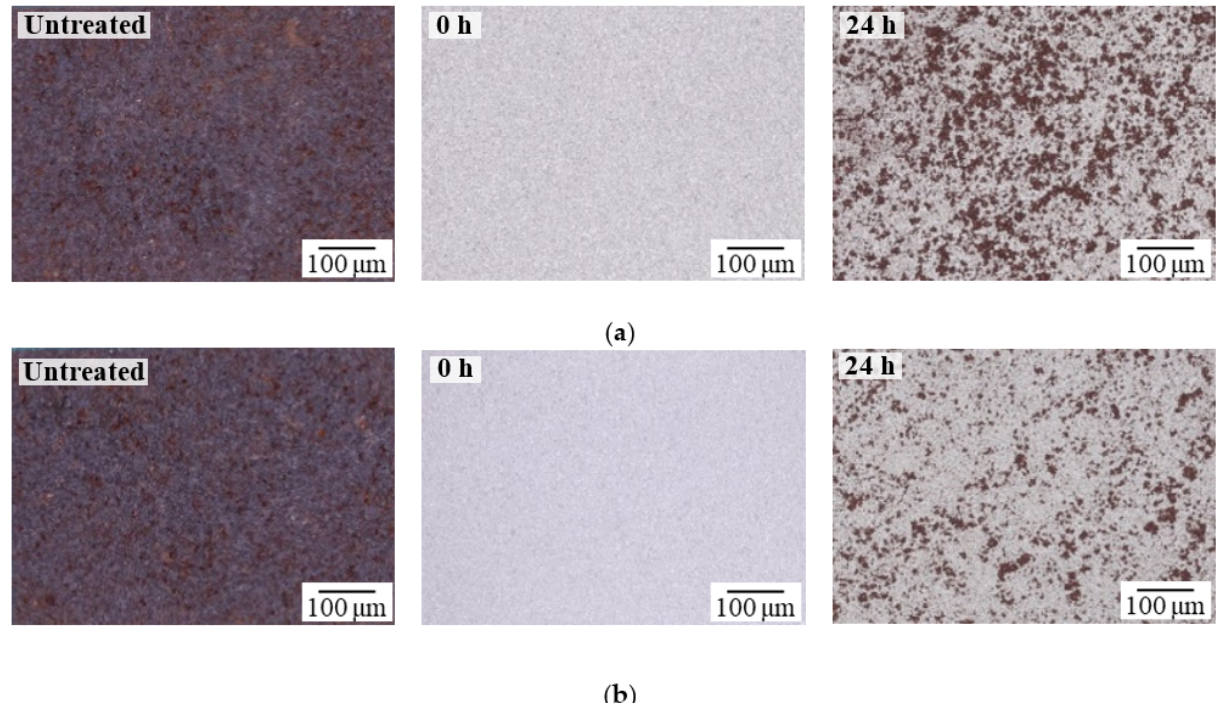
Figure 16. Surface morphologies of the blasted surfaces after 0 and 24 h exposure: ( a ) CST, ( b ) CAL. The fracture surface conditions after the adhesion tests on the unpainted and painted surfaces after 0 and 24 h of exposure for CST and CAL are shown in Figures 17 and 18, respectively. The adhesion strength results according to blasting conditions are shown in Figure 19. After pull-off tests were performed, the adhesion strength results and failure types were analyzed separately. Overall, the failure type was the same under all conditions, namely, a combination of cohesive failure and adhesive failure. In addition, images of both CST and CAL corresponding to 0 h of exposure showed that adhesive remained on the dollies, which indicated that the adhesion to the substrates was larger than or approximately the same as the stress applied to the adhesive. Figure 17 shows that after 24 h of exposure, adhesive remained on both the substrate and dollies after the adhesion test. In addition, the fracture of the paint confirmed that, although this fracturing occurred inside the coating under all conditions, regardless of the blasting conditions, the fractures were separate from the position of rust debris. The visible rust on the substrates also corresponded to residual adhesive, with rust-colored areas on the dollies that were isolated or surrounded by a thin layer of adhesive. It was concluded that the initial failure started at the location of rust, and stress concentrations formed around the large (microscale) particles at the poles; thus, a cavity might grow by tearing the material at the inner surface with respect to the stress direction [28]. Therefore, the surface condition has a severe impact on the adhesion. During the 24 h interval, the adhesion decreased by 30% for CST and by more than 20% for CAL. CST exhibited a greater reduction in adhesion owing to the larger corrosion area. This finding confirmed that the alumina residue is beneficial in steel construction applications and increases adhesion as a corrosion